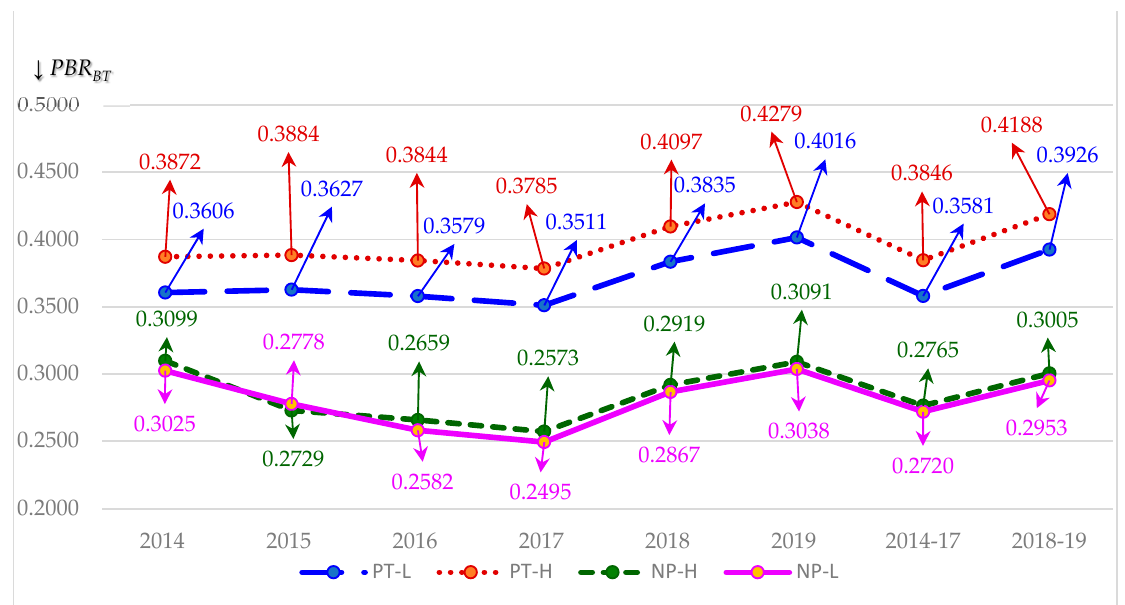
Figure 8. Before-tax plowback ratio ( PBR BT ) values are plotted along the vertical axis against six years (where annual credit spreads are different) and two periods (where annual credit spreads are averaged) along the horizontal axis. The four trajectories are NP- L trajectory, solid line; NP- H trajectory, small dashed line; PT- L trajectory, large dashed line; and, PT- H trajectory, dotted line. We use pre-TCJA tax rates for 2014–17 with 3.12% growth rate and TCJA tax rates for 2018–2019 with 3.90% growth rate. Both the low ( L ) and high ( H ) tax rates are used where the growth ( RE ) constraint sets in after Ba1 for nonprofits (NPs) and after Ba2 for pass-throughs (PTs). As seen in Table 6, the optimal credit rating ( OCR ) varies over time with an OCR of A3 for the last two years of 2018 and 2019 for both NPs and PTs.